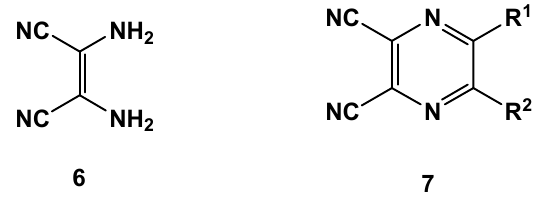
Figure 3. Structures of DAMN 6 and pyrazine-2,3-dicarbonitriles 7.